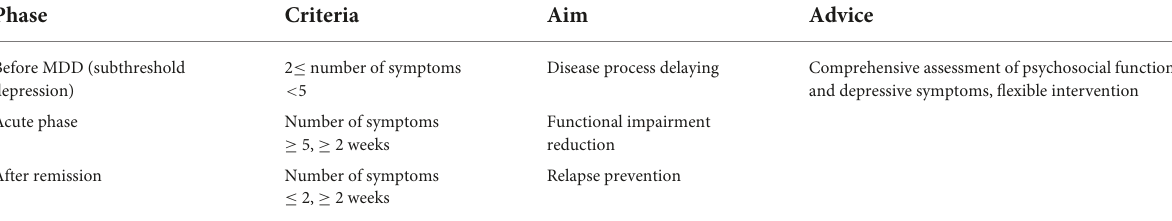
TABLE 2 Difference phases in major depressive